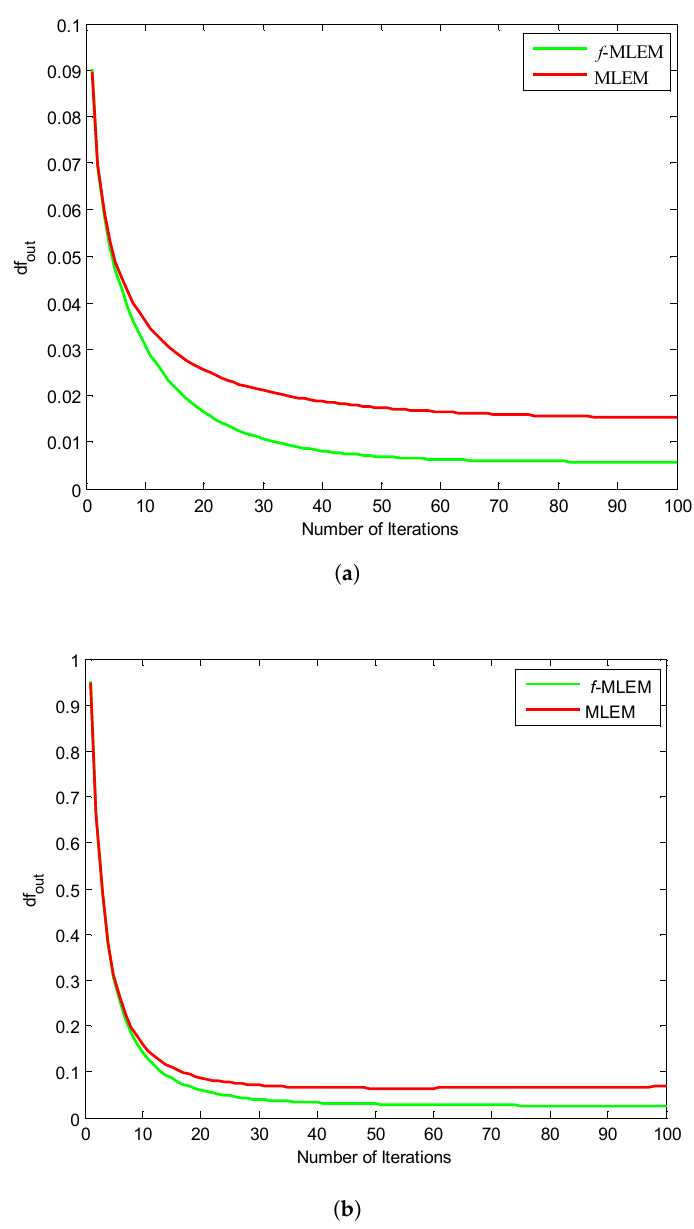
Figure 11. SNR vs. the number of iterations for ( a ) Huffman Brain and ( b ) Abdomen Phantom images. It can easily be seen that the performance parameters are considerably improved compared to those of the conventional MLEM, particularly for 50 iterations, and the perfor- mance parameters remain almost constant after this number. It should be noted here that the number of iterations is necessary to improve and refine the quality of a reconstructed image. Both the quality measurements (SNR) and the relative norm errors ( d f ) clearly reveal that the performance of the conventional MLEM algorithm after 100 iterations is similar to the performance of the f -MLEM at 22 iterations, as shown in Figures 10a and 11a. The proposed algorithm requires a minimum of around 20 iterations to display an accept- able reconstructed image. This is the most common method for eliminating star artifacts that are usually generated with a conventional MLEM algorithm. The proposed f -MLEM algorithm is fast and efficient because it provides the best reconstructed images after a sufficiently small number of